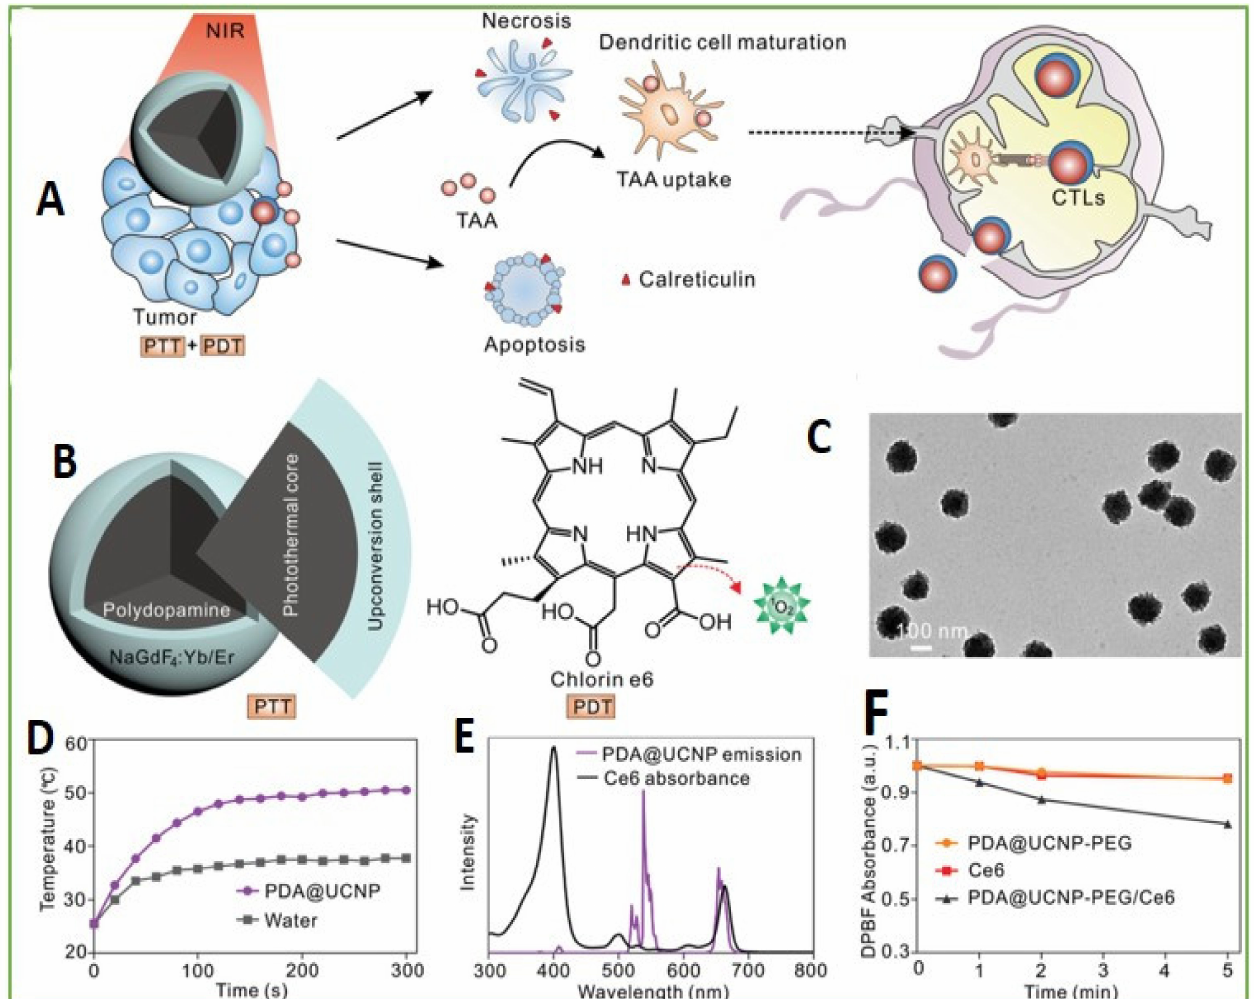
Figure 3. Design of PDA@UCNP-PEG/Ce6. ( A ) Scheme for synergistic phototherapy. Upon laser irradiation, the UCNP- based system can ablate the tumor, tumor-associated antigens (TAA) are released and the antitumor immunity is triggered. Finally, it helps the inhibition of tumor metastasis. ( B ) The UCNP structure: core for PTT and the shell for PDT. ( C ) TEM images of PDA@UCNP. ( D ) Temperature variation with irradiation time of PDA@UCNP nanoparticles (2 mg mL − 1 ). ( E ) Ce6 absorption and PDA@UCNP emission upon 980 nm laser excitation. ( F ) 1 O 2 generation comparison upon 1 Wcm − 2 laser irradiation. Adapted with permission from